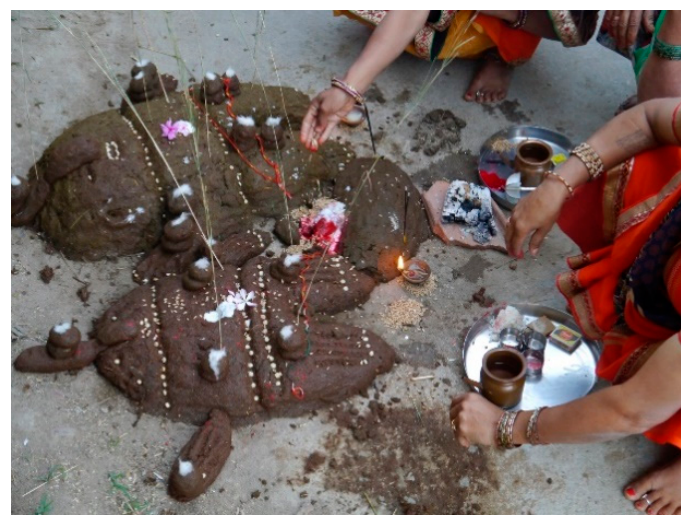
Figure 11. Mixing seeds and liquids during the ritual worship of Govardhan, Havala 2017 (picture by author).